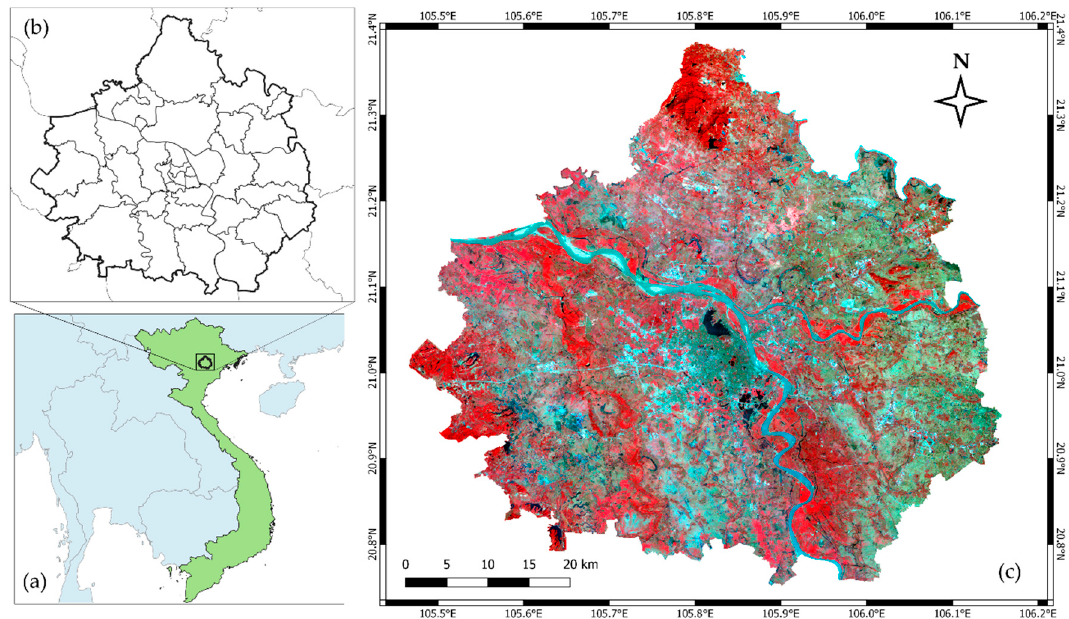
Figure 1. Location of the study area in Vietnam ( a ); Hanoi and its surrounding districts within a radius of 30 km ( b ); the 2010 Landsat 5 Thematic Mapper (TM) image false color composite (RGB: 432), clipped to the extent (coordinate system: WGS84) of the study area ( c ).